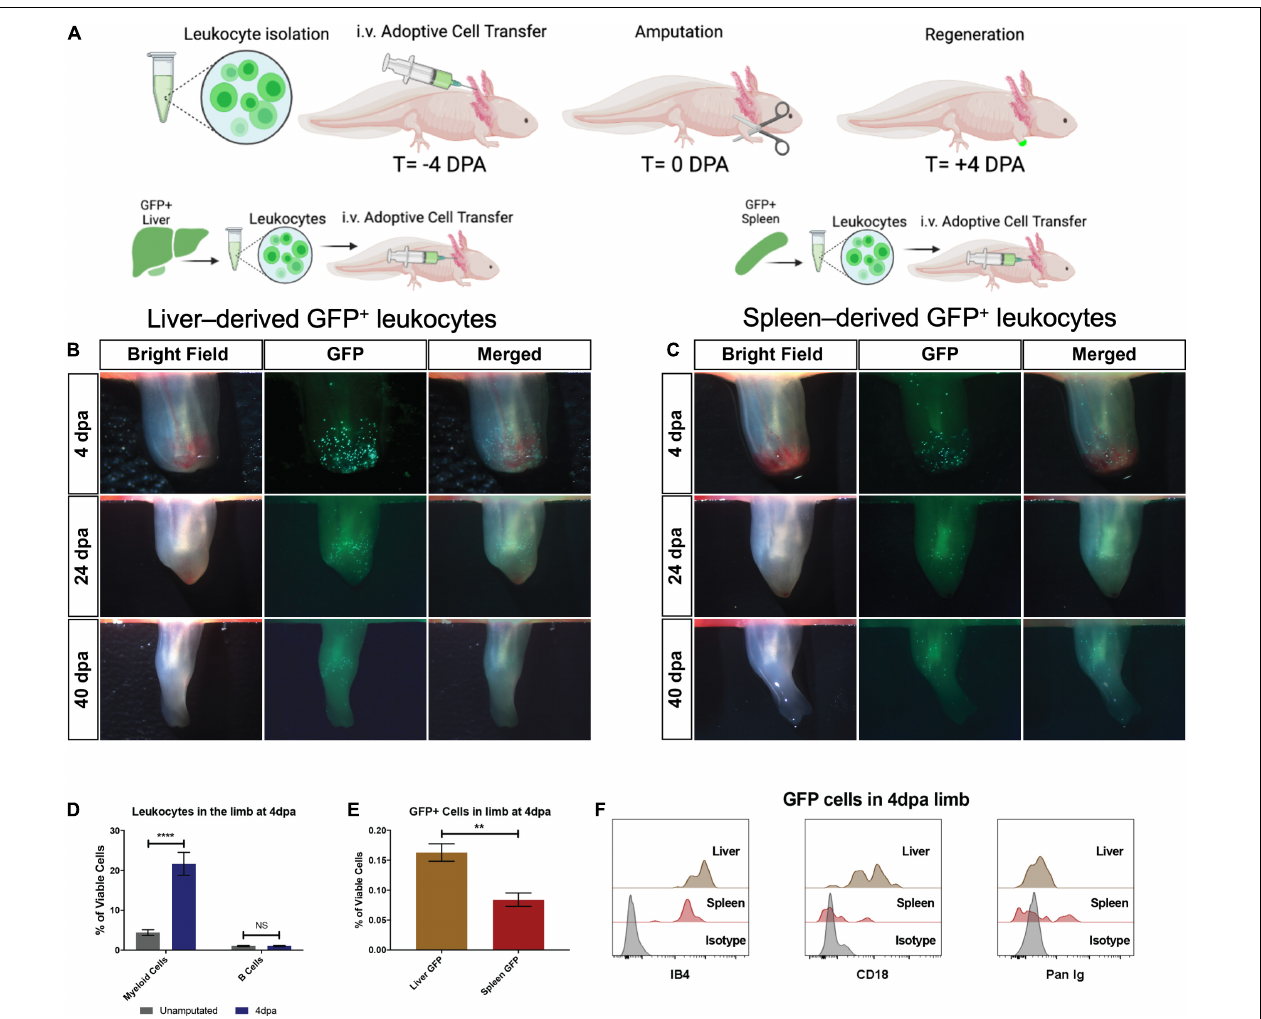
FIGURE 4 | The liver is the dominant contributor of myeloid cells during limb regeneration. (A) Experimental strategy to identify cellular contributions from the liver and spleen following transplantation of 5 × 10 5 live GFP + cells. (B,C) Representative live imaging of the regenerating host limb at the wound healing (4 dpa), blastema outgrowth (24 dpa), and re-development (40 dpa) stages of limb regeneration. Liver-derived GFP + cells are most abundant during the wound healing stage (4 dpa) and reduce in number throughout later stages of regeneration. Spleen derived GFP cells are recruited to the limb but qualitatively less in number compared to liver transplanted cells. N = 12 biological replicates. (D) Quantitation of myeloid cells and B cells in the limb at 4 dpa using CD18/IB4 and Pan-Ig staining, respectively. Bar graphs show mean ± SEM of four biological samples. p -Values obtained via one-way ANOVA with comparisons to the unamputated sample. **** p ≤ 0.0001. (E) Quantitation of viable GFP + cells in the early regenerating limb following liver or spleen transplantation. Bar graphs show mean ± SEM of three biological samples. p -Values obtained via one-way ANOVA. ** p ≤ 0.01. (F) Flow cytometry histograms of GFP + cells in the limb testing for myeloid cell identity (CD18) in the second plot and B cell identity in third plot. T, time; DPA, days post amputation. ns, not significant.